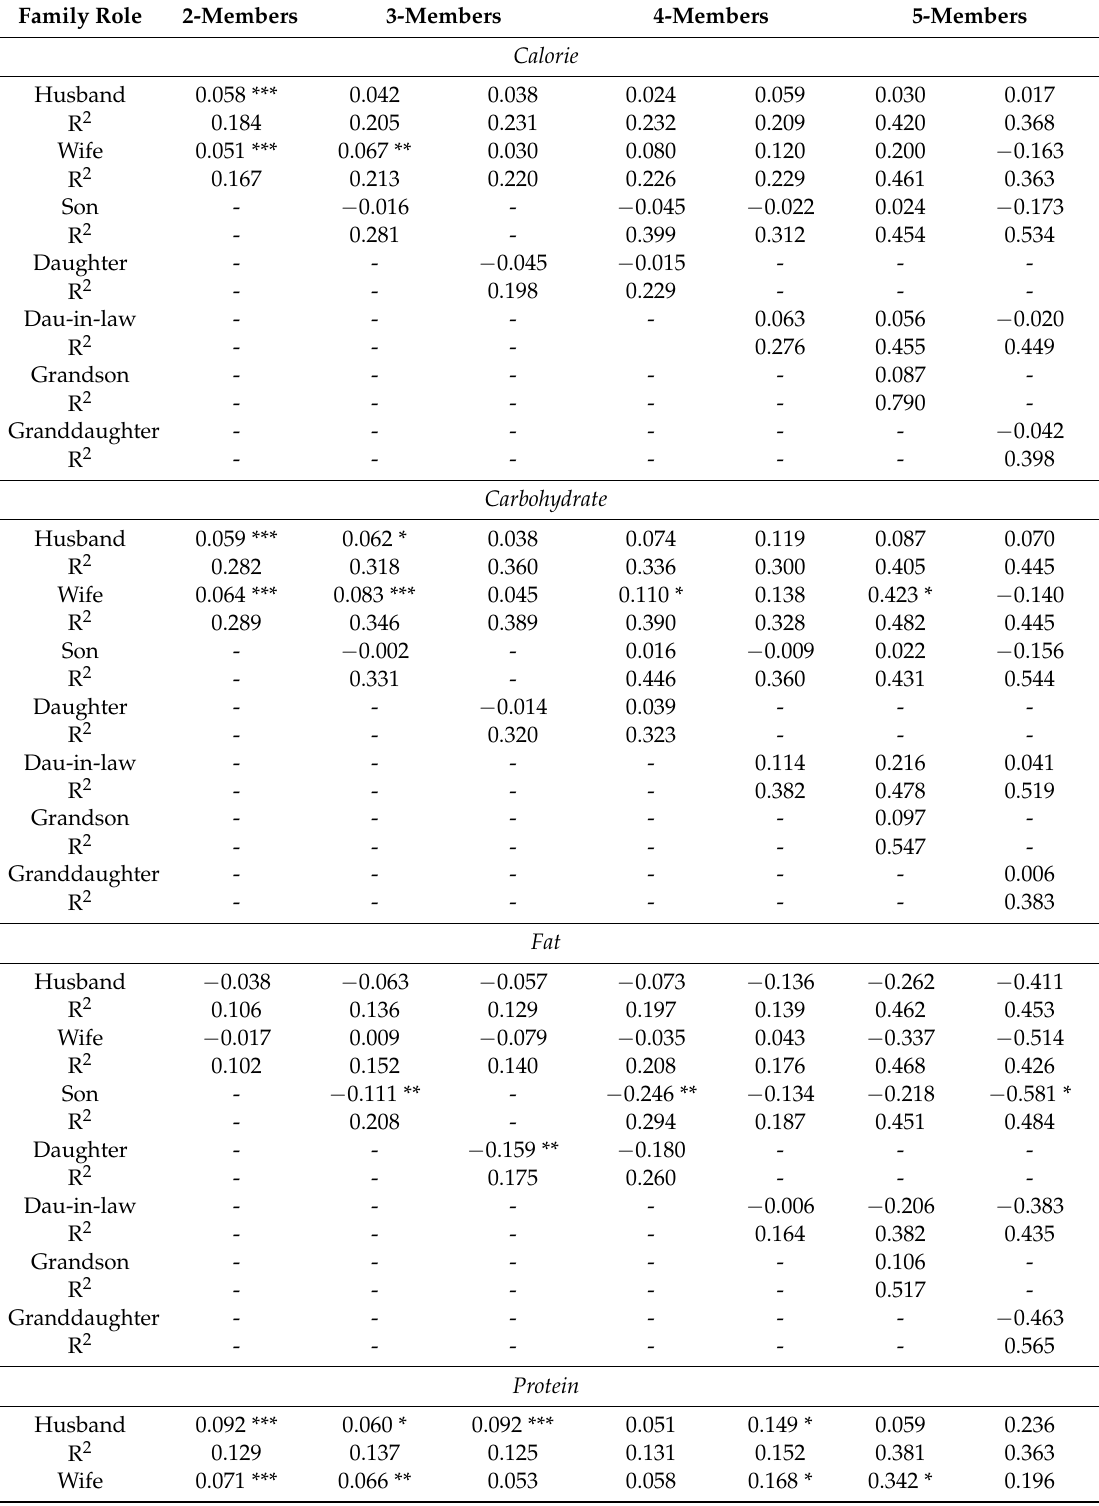
Table 4. Urban multiple members’ joint consumption effect (dependent variable: ln individual calorie, carbohydrate, fat and